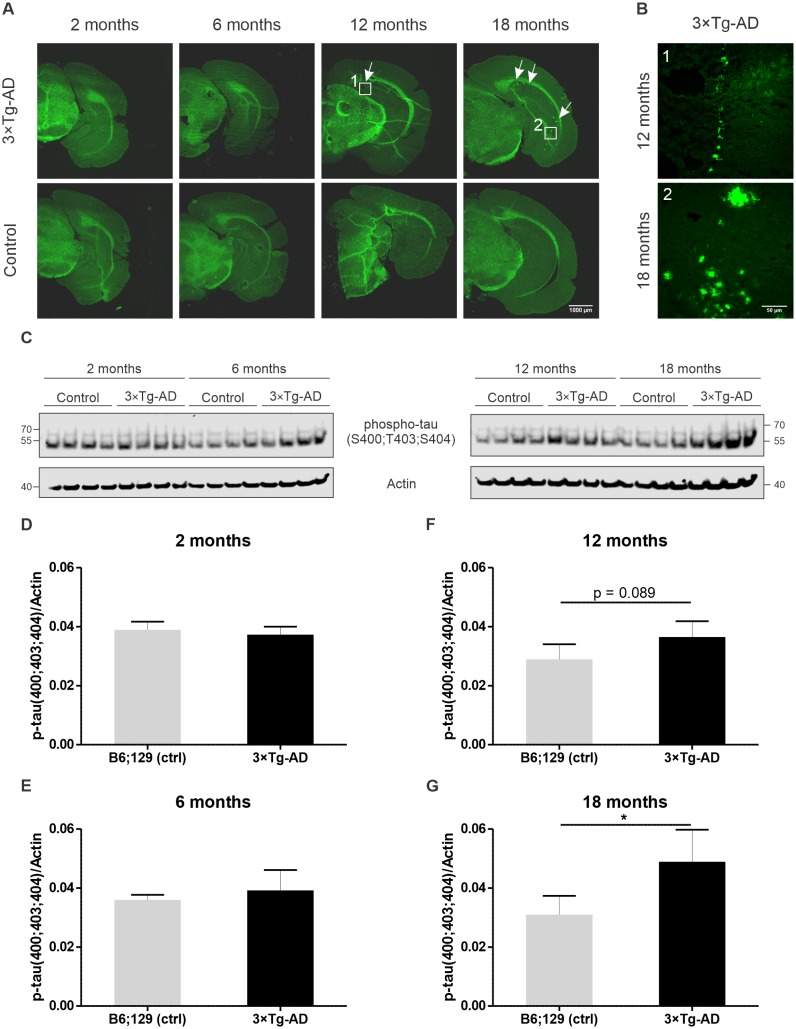
Assessment of pathology in 3×Tg-AD mice used in this study.(A) Thioflavin S staining of brain sections from 3×Tg-AD and control mice was performed for each analyzed time point to monitor the aggregation of fibrillar material with β-pleated sheet conformation. Accumulation of Aβ plaques assayed by thioflavin S staining at each analyzed time point in 3×Tg-AD and control mice. Representative images of coronal sections including the hippocampal formation with the subiculum were acquired. White arrows indicate exemplary Aβ plaques. (B) High magnification images of Aβ plaques in 12 and 18-month-old 3×Tg-AD mice. (C) Assessment of tau phosphorylation at sites S400/T403/S404 by immunoblotting. Soluble fractions of brain proteins obtained from one of the sagittal halves of harvested mouse whole brains (four animals per background and timepoint) were used for the analysis. (D–G) Relative quantification of tau phosphorylation. Slight upregulation of phospho-tau can be observed at the time point 12 months in 3×Tg-AD mice. Significantly different levels of tau phosphorylation were detected at the late stage of the disorder (18 months). All bar charts represent mean ± SD. Statistical significance in the datasets was assessed by Student’s t-test: *p value < 0.05.